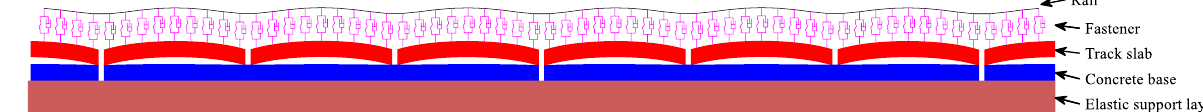
Figure 1. The schematic of initial deformation and gap caused by the temperature gradient of ballastless